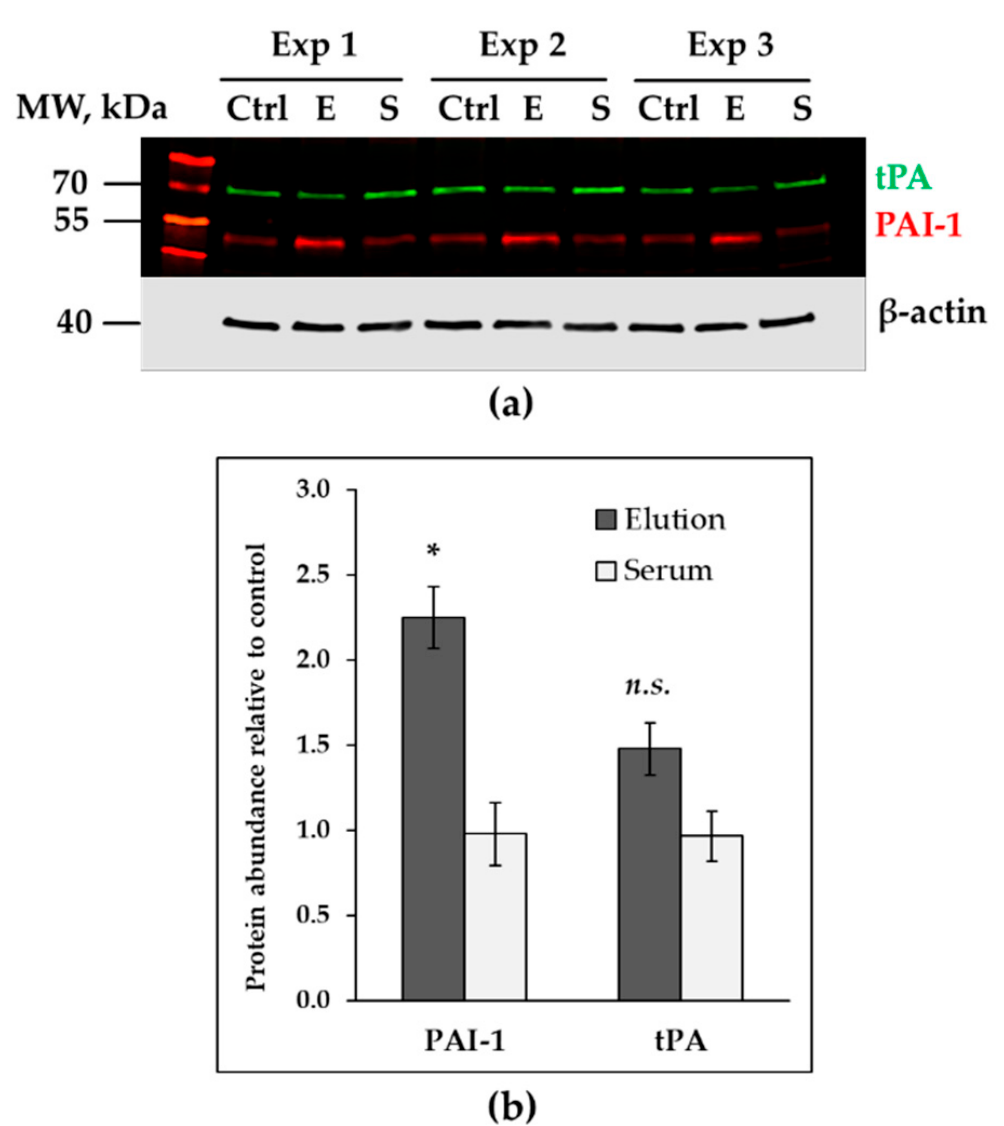
Figure 4. Increased expression of PAI-1 in HAECs, treated with proteins eluted from CytoSorb adsorber matrix ( n = 3). ( a ) Immunodetection of tPA and PAI-1 in cell lysates obtained from untreated HAECs (Ctrl), HAECs treated with 0.125 µ g/mL of elution € , 0.125 µ g/mL of serum (S).